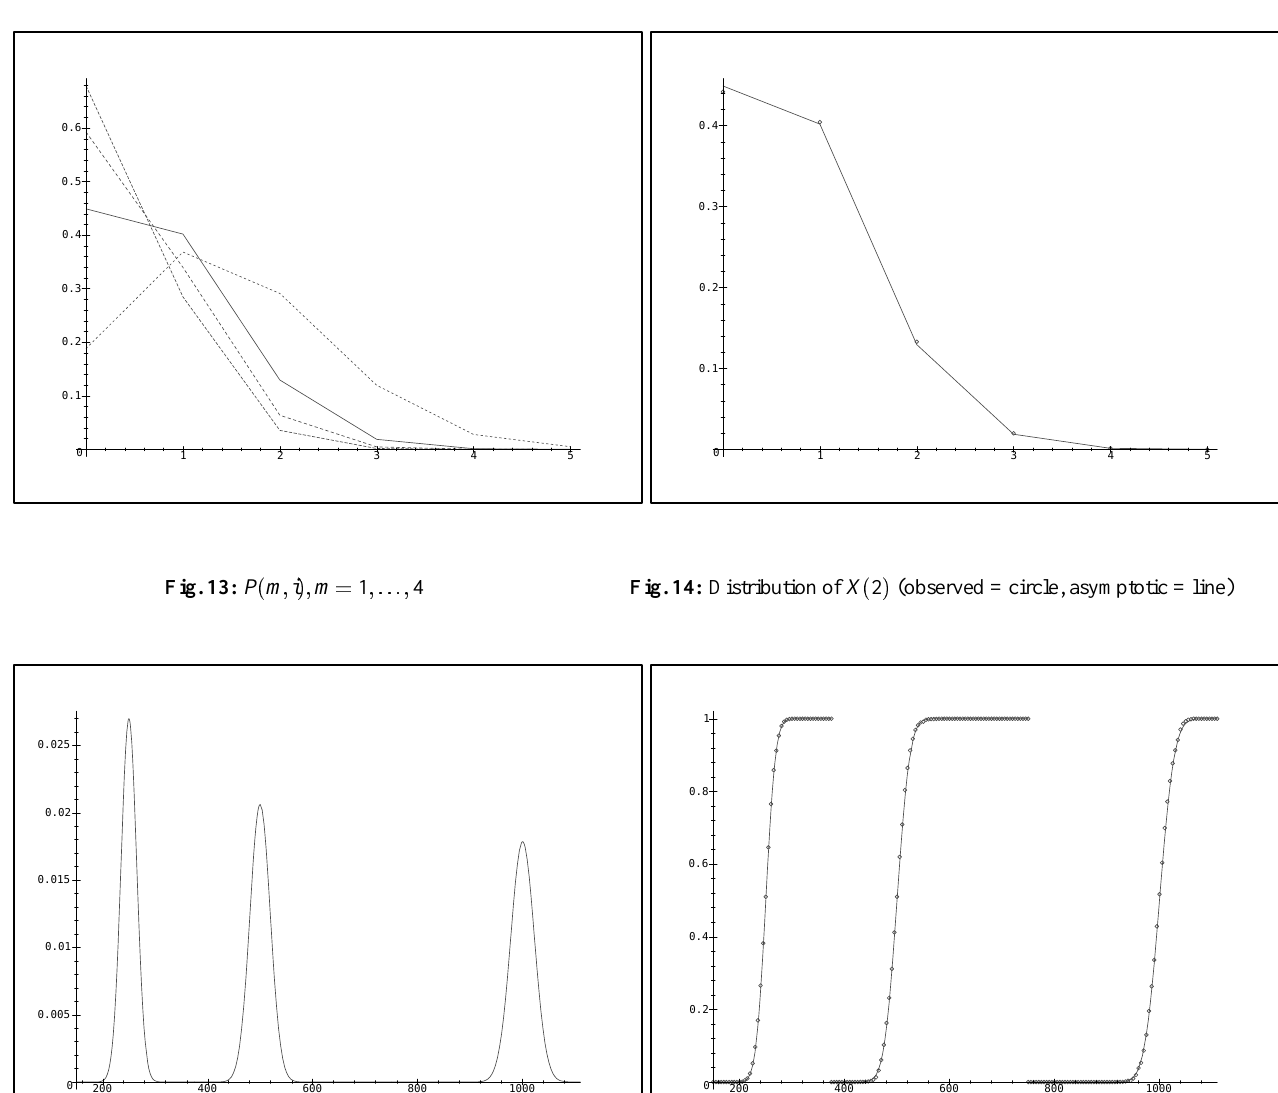
i (cid:0) 1 3 (observed = circle, (cid:2) (cid:2)(cid:0)(cid:0)(cid:0)(cid:2)